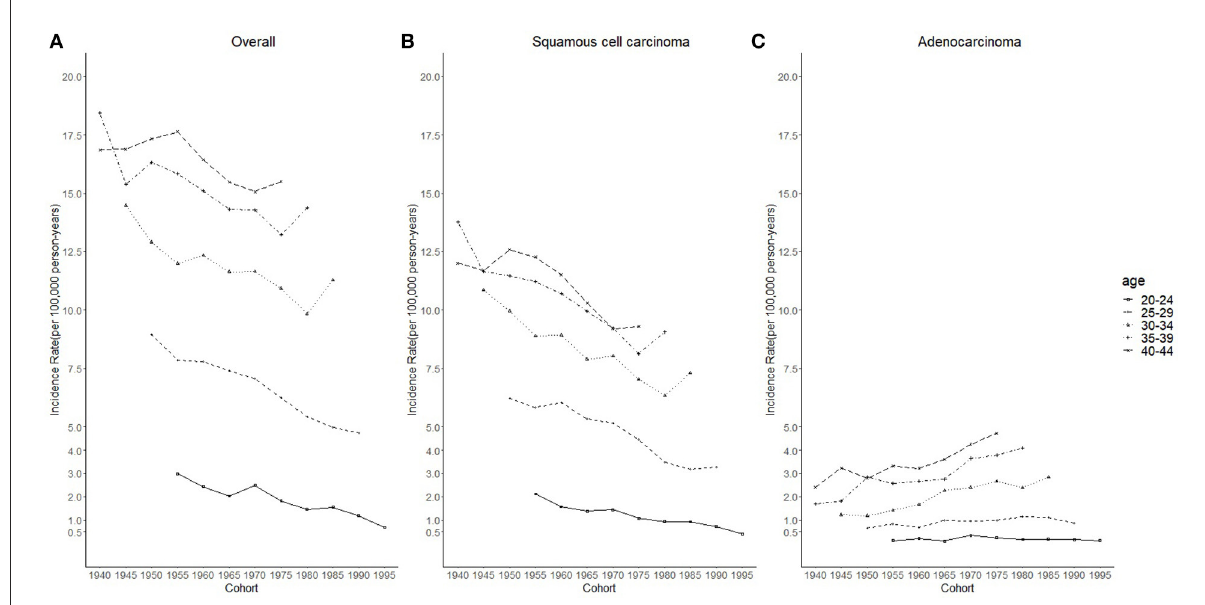
FIGURE3 Cohort trends in cervical cancer incidence rates (1975–2019) among females aged 20 to 44 years by age and histology, United States. (A) Cohort trends of all histopathologic subtypes combined. (B) Cohort trends of squamous cell carcinoma (SCC). (C) Cohort trends of adenocarcinoma (AC). All data are expressed as the rate per 100,000.